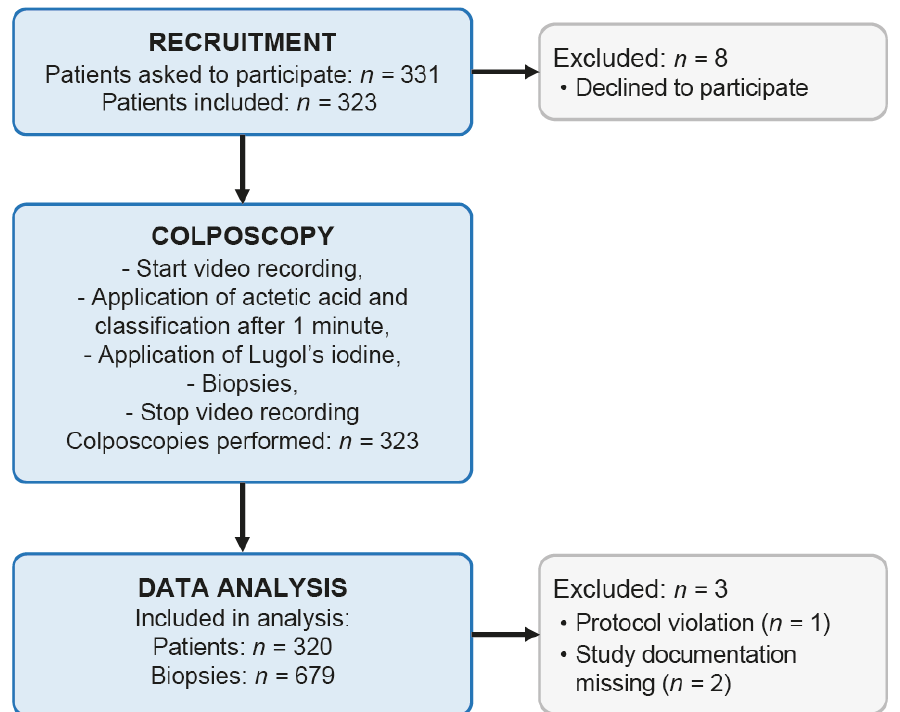
Figure 1. Flow diagram of the study and analysis. Table 1. Patient characteristics, colposcopy, and histopathology.